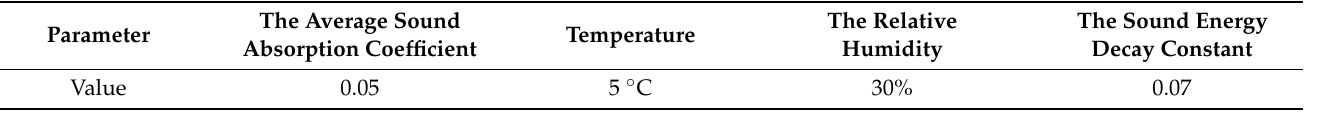
Table 3. Indoor environment Table 1. Basic parameters of the experiment.